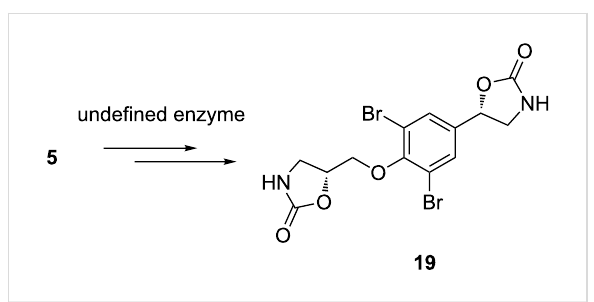
Figure 4: The tissue damage induced chemical conversion from fistu- larin-3 ( 5 ) to 19 by an undefined enzyme in the sponge Aplysina spp. [36].